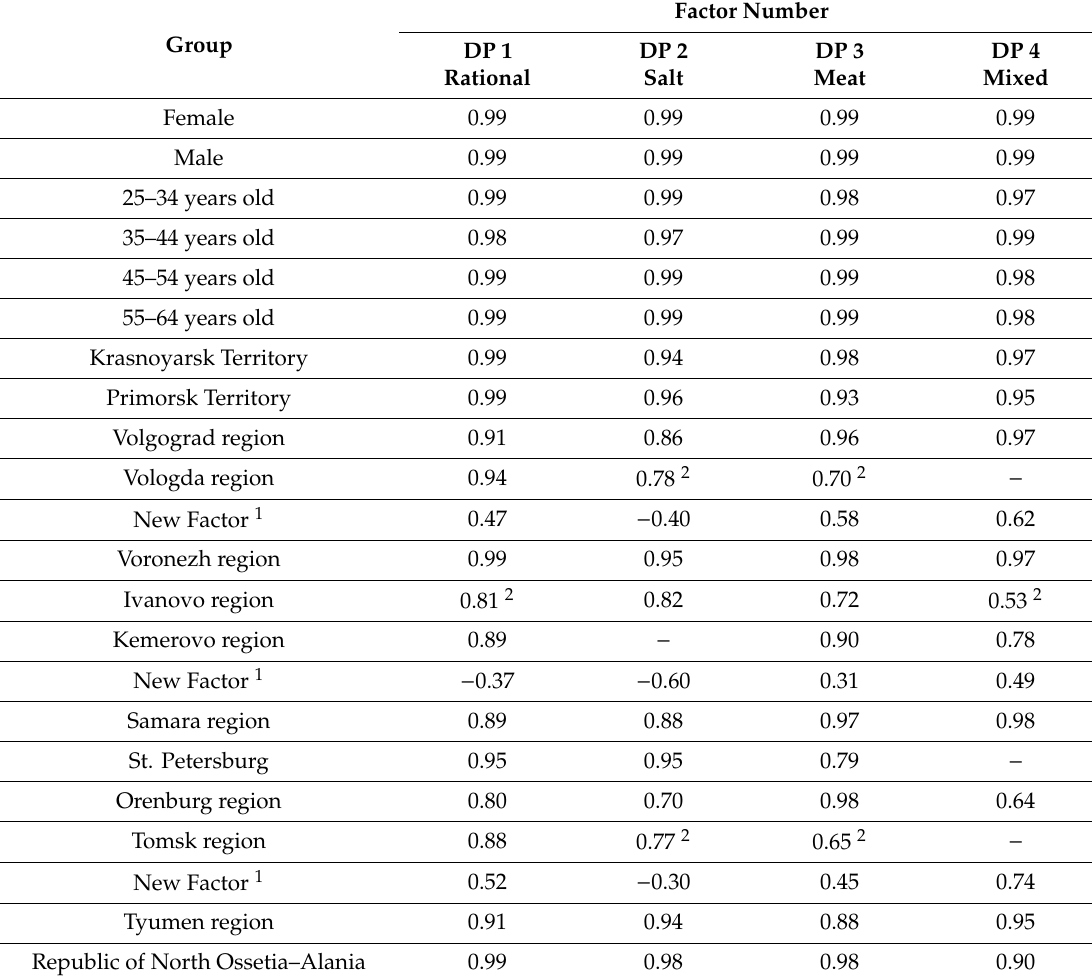
Table 3. Factors congruent in factor solutions by gender, age, and region in comparison with factor solutions in the general